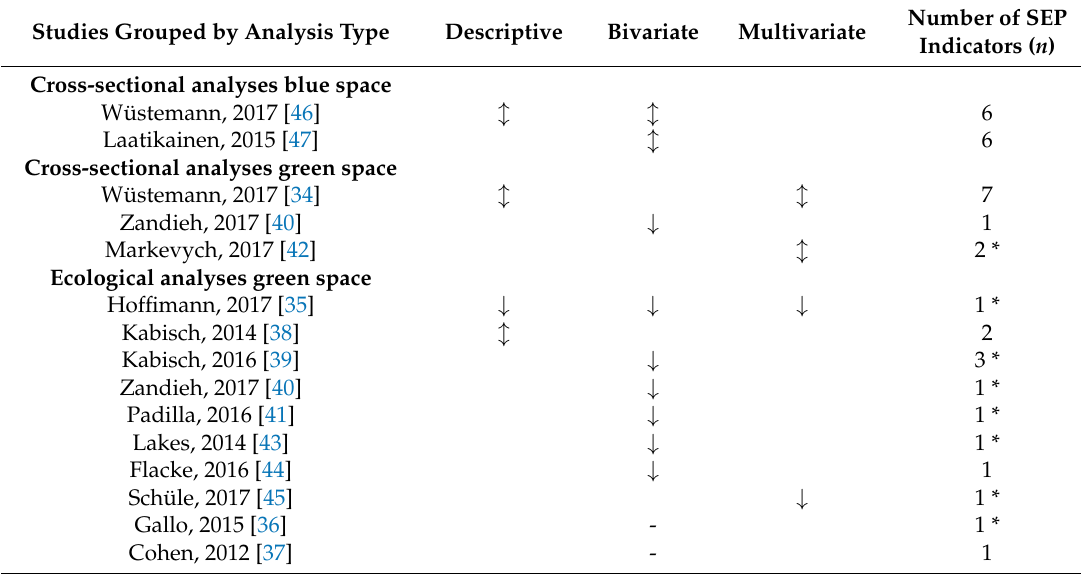
Table 3. Summary of relationships between socioeconomic position (SEP) and environmental resources across studies, and number of analysed SEP